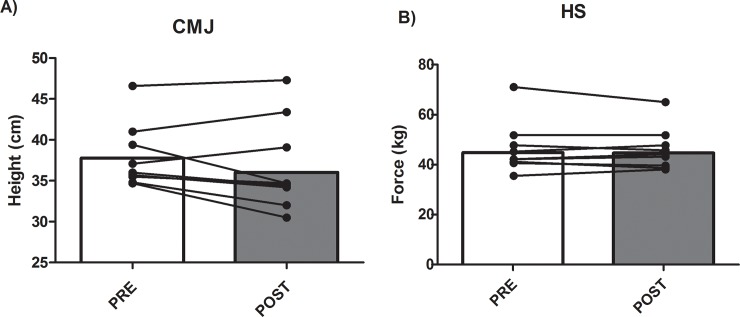
Neuromuscular performance before and after a professional tennis match.Bars are means. Individual responses are displayed as points linked with lines. CMJ, counter-movement jump; HS; handgrip isometric strength.